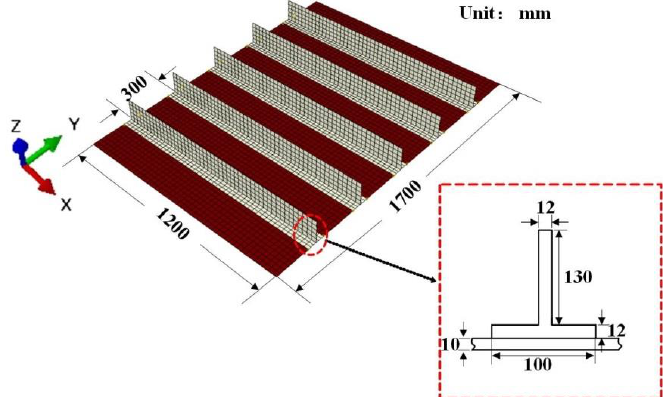
Figure 1. Scantlings of the GFRP stiffened panel in ship deck.